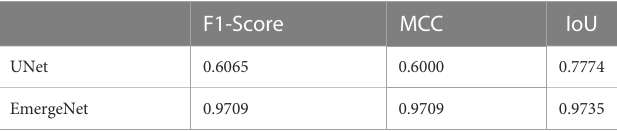
TABLE 2 Results of comparison between UNet and EmergeNet on UNL- MED only under dark environmental conditions in terms of F1-Score, MCC, and